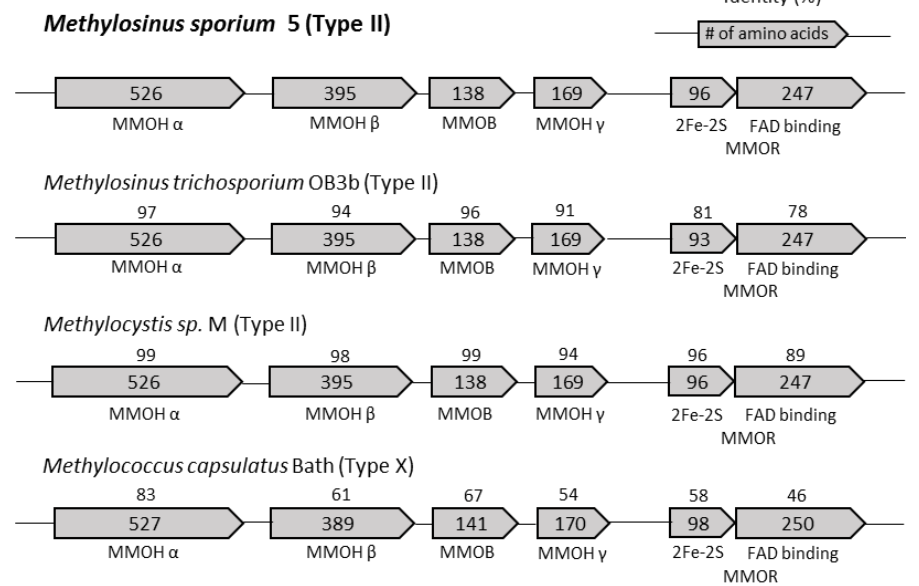
Figure 1. Multiple sequence alignments of amino acid sequences of soluble methane monooxygenase (sMMO) from type II and type X methanotrophs. Numbers above boxes represent the sequence identity to sMMO from M. sporium 5, and numbers inside the box represent the number of amino acids in each enzyme and domain.